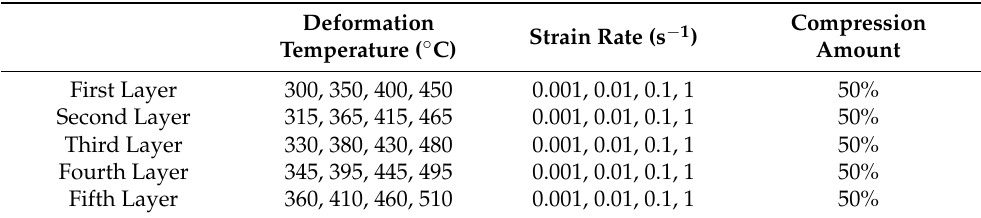
Figure 2. The sampling location for gleeble test and sample sizeAn isothermal and constant strain rate compression deformation was performed on a Gleeble-1500 testing machine (Dynamic Systems Inc., New York, NY, USA) for hot working simulation. To reduce the friction between the indenter and the sample, graphite was applied as a lubricant on both ends of the sample during compression, which ensured the sample was under unidirectional axial stress during compression. A thermocouple was welded on to the surface of the middle part of the sample to accurately measure the temperature change of the sample during the experiment. The experimental parameters are shown in Table 2. Table 2. Deformation parameters of the deposited